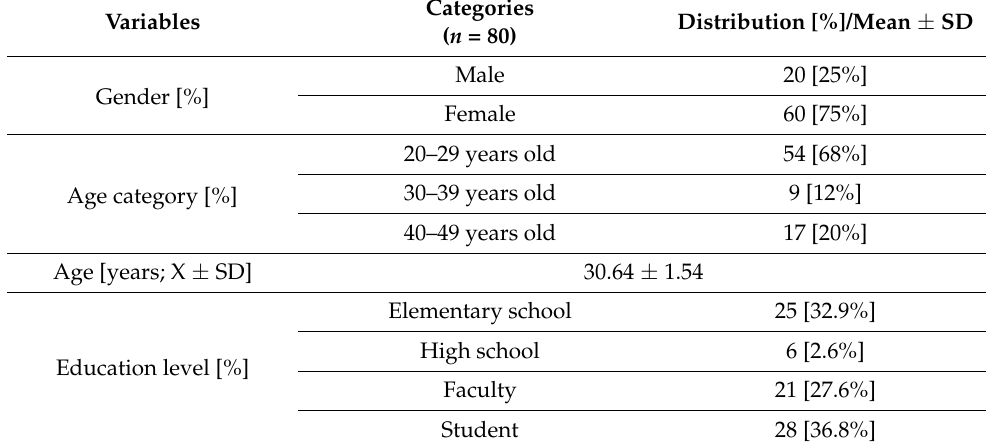
Table 1. Basic socio-economic characteristics of the study population ( n = 80). Results are presented as distributions [%]/mean ± stand.